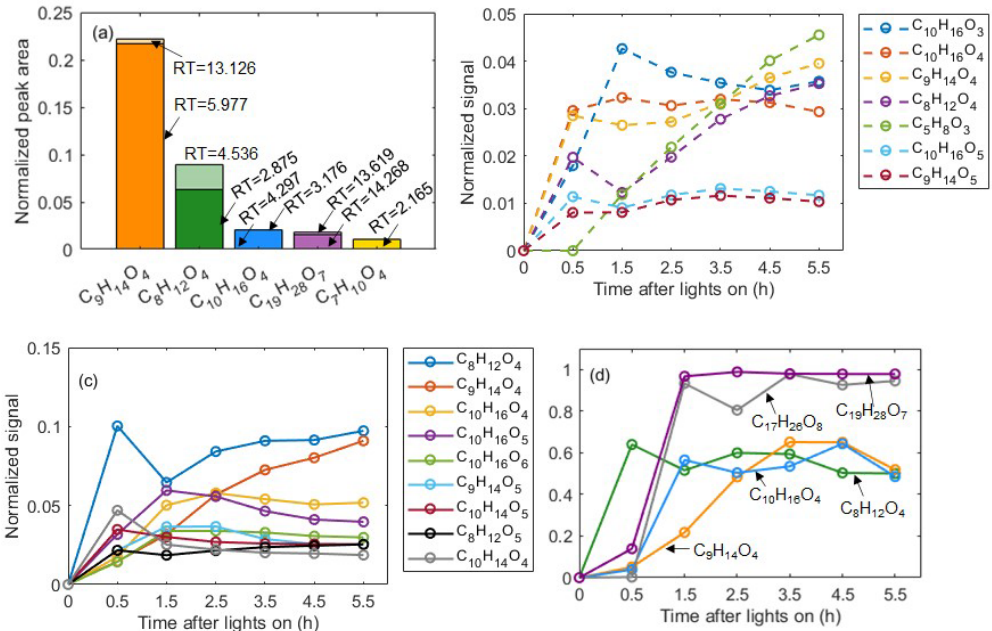
Figure 7. (a) Isomeric fractions of ions from LC-Orbitrap MS analysis. (b) Time series of compounds in the gas phase from CIMS gas-phase measurements. (c) Time series of compounds in the particle phase from CIMS particle-phase measurements. (d) Temporal profiles of particle fractions for a few identified organic molecules generated from α -pinene photooxidation reactions. Table 2. Molecular information ordered by carbon number and estimated C ∗ of compounds obtained from the partitioning theory method and structural information method. The uncertainty of the Log C ∗ from the partitioning theory method was from the uncertainty of measured F p and was propagated 1 standard